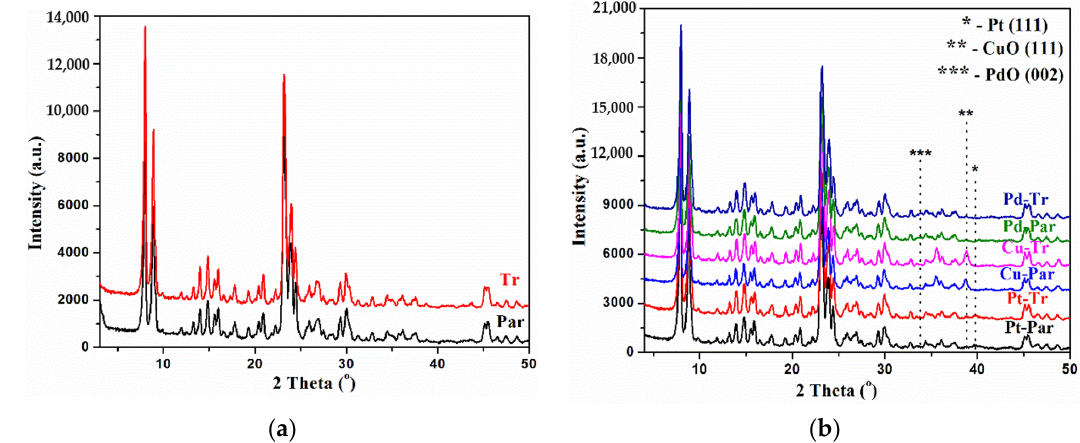
Figure 1. XRD patterns of ( a ) parent and treated ZSM-5 samples; ( b ) parent and treated impregnated with Pt, Cu, and Pd.